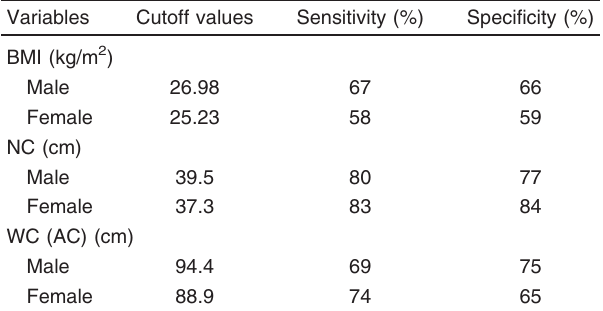
Table 6 Accuracy, sensitivity, and specificity of the possible optimal cutoff values of the individual anthropometric indices for predicting the presence and severity of obstructive sleep apnea